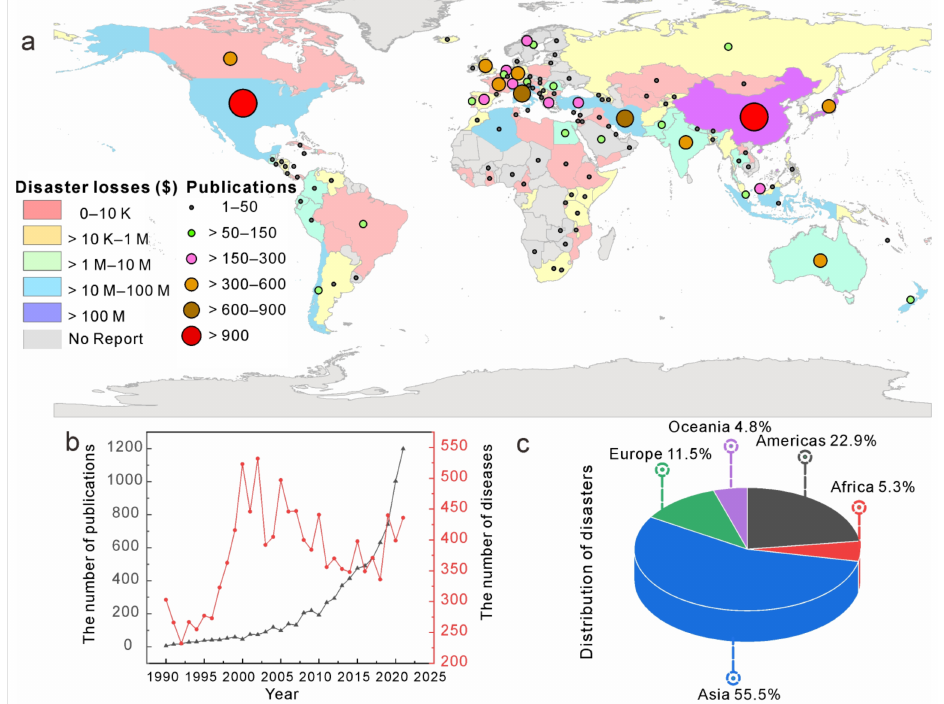
Figure 1. ( a ) The distribution of geohazard loss (Source: https://public.emdat.be/data, accessed on 7 July 2022) and the number of papers. Different colors indicate different degrees of geohazard loss and the size and color of the circles indicate the number of papers published in that country. ( b ) The change in the number of geohazards and the number of publications over time. ( c ) The regional distribution of the number of